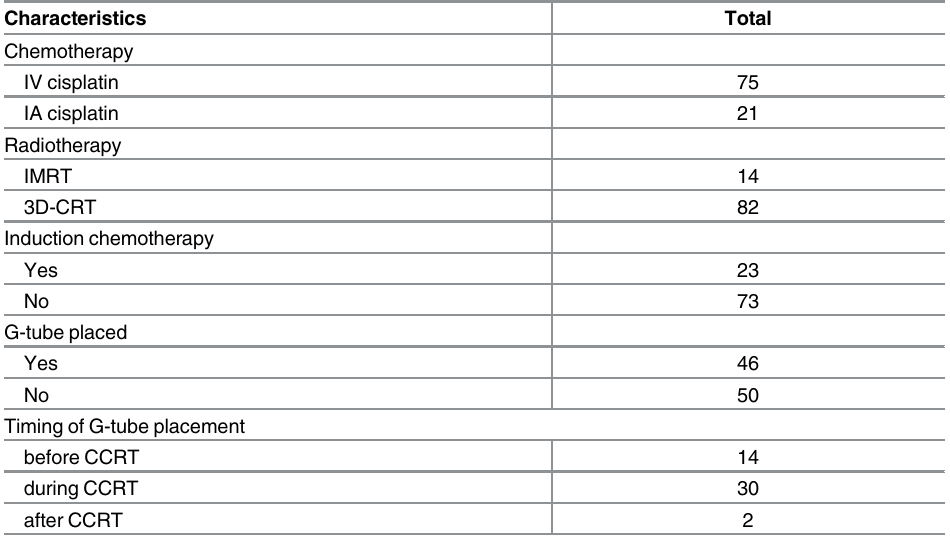
Table 2. Treatment details and G-tube placement.